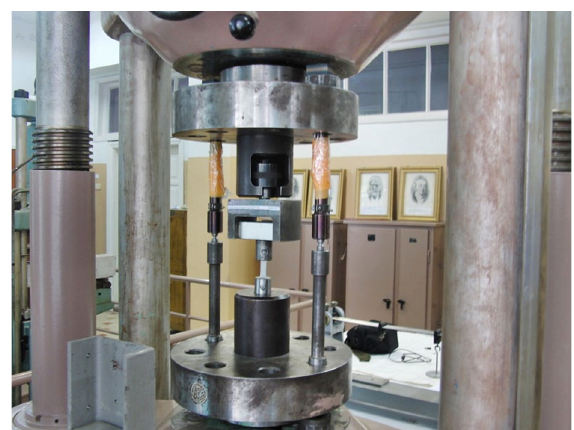
Fig. 2. General view of the inner-contour of the loading